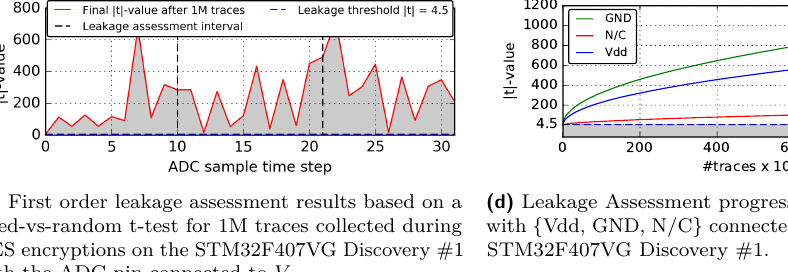
Figure 15: Results of Leakage Assessment on STM32F407VG Discovery #1 for mbedTLS AES.